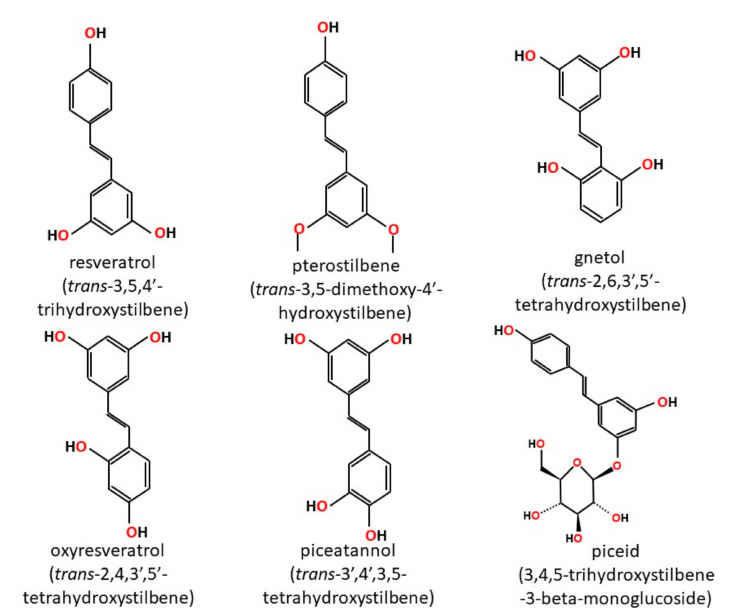
Figure 1. Chemical structures of selected stilbenoid phenolics showing common stilbene backbone.